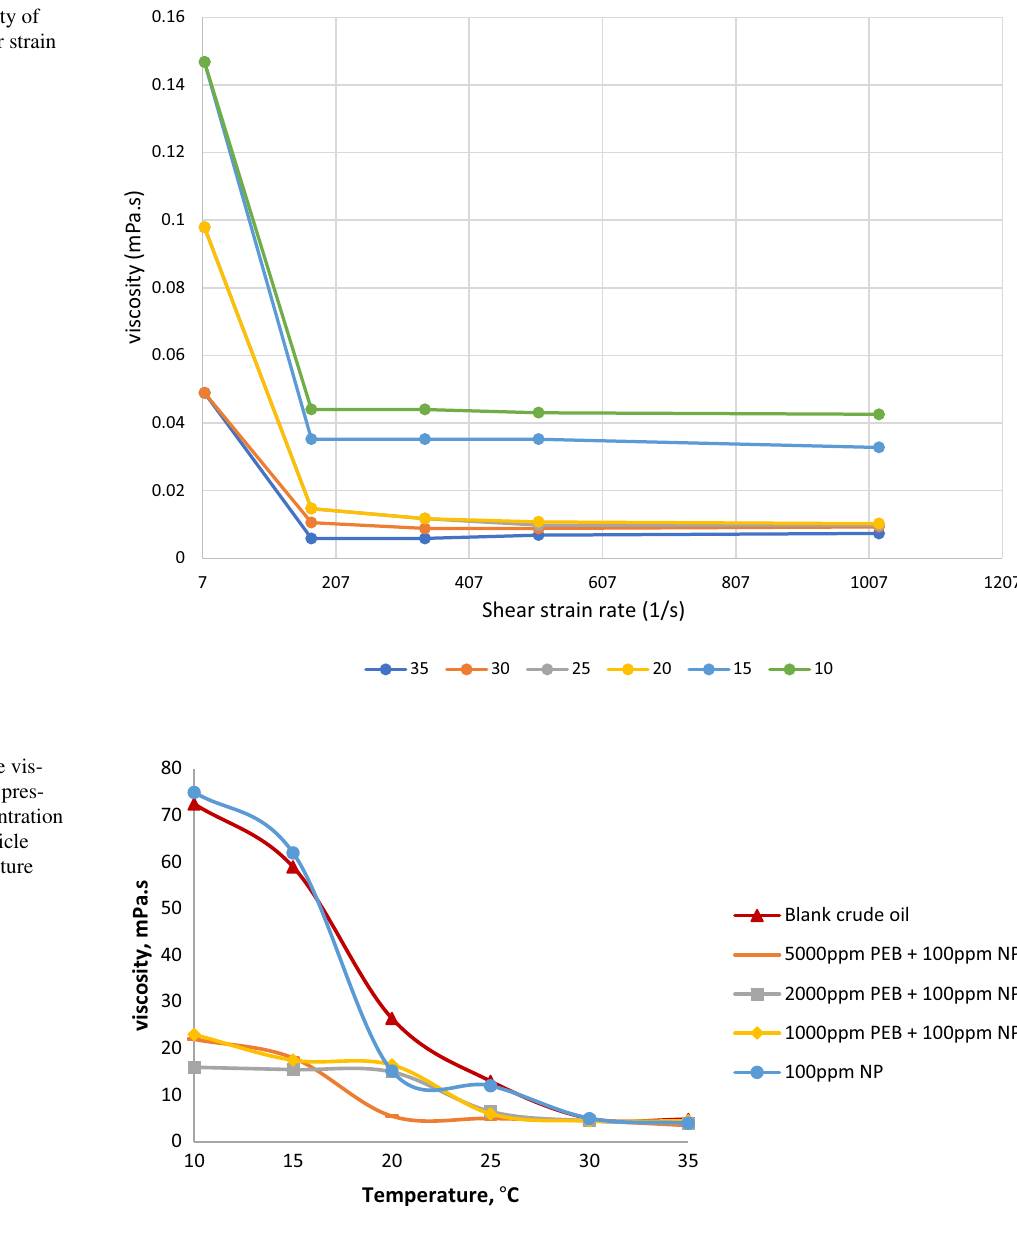
Fig. 6 Plot of the viscosity of blank crude against shear strain rate